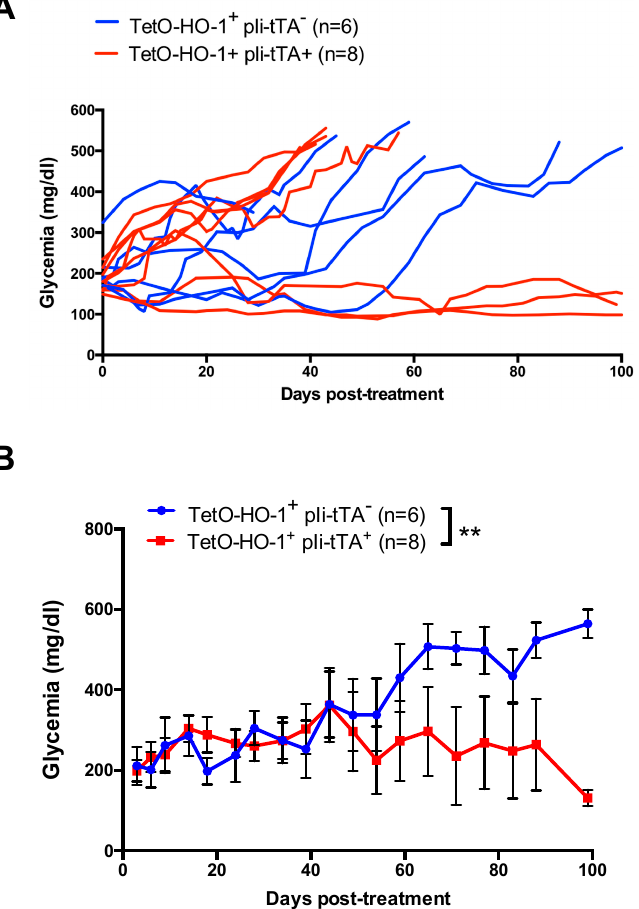
Figure 5. HO-1 induction in DCs inhibited diabetes in spontaneously diabetic mice. Diabetic mice with a glycemia between 200 mg/dL and 250 mg/dL for two consecutive days were identified in